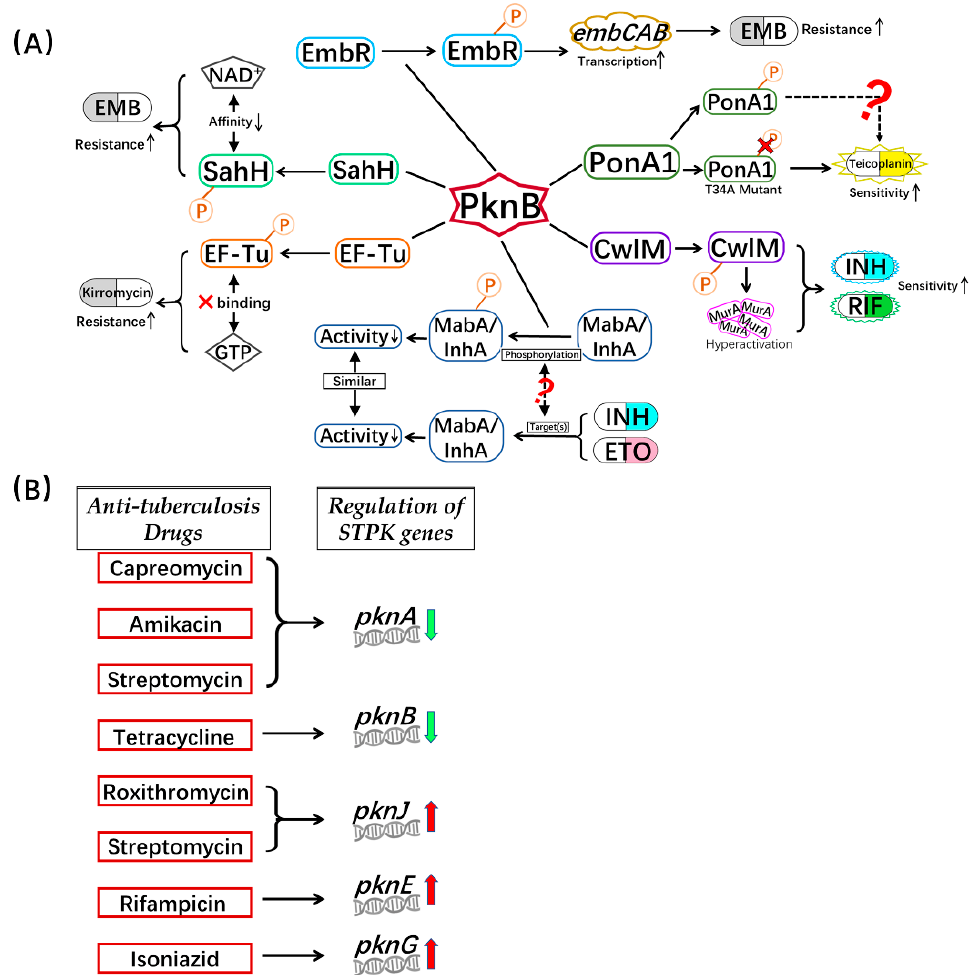
Figure 2. Connections of anti-tuberculosis drugs resistance and protein phosphorylation in MTB. ( A ) PknB mediates drug resistance/tolerance by phosphorylation; ( B ) Regulation of STPK genes af- ter treatment with anti-tuberculosis drugs. EF-Tu, elongation factor Tu; EMB, ethambutol; ETO,